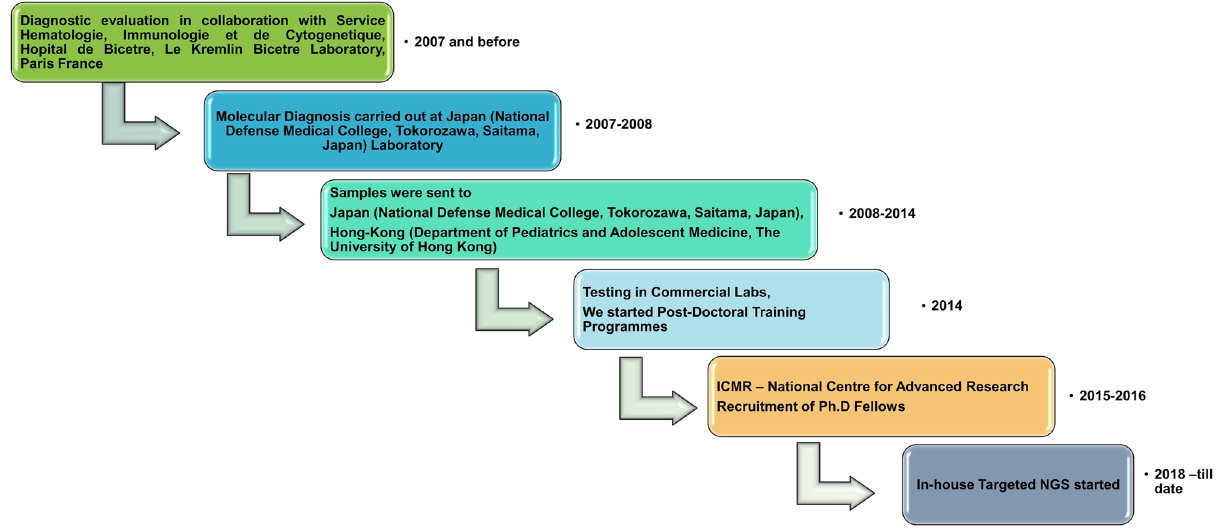
Figure 1. Evolution of molecular diagnosis of patients with IEIs at Allergy Immunology Laboratory, Advanced Pediatric Centre, Chandigarh,